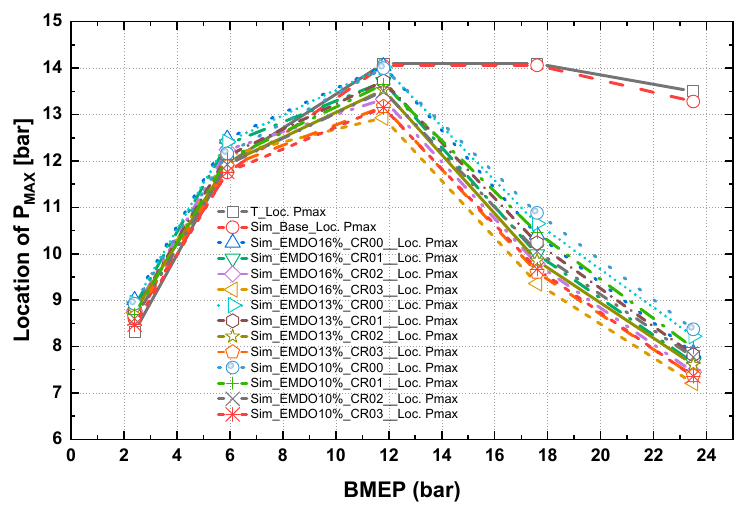
Figure 7. Characteristics of the location of the peak combustion pressure versus the compression ratio of the turbocharger and three types of emulsified MDOs.